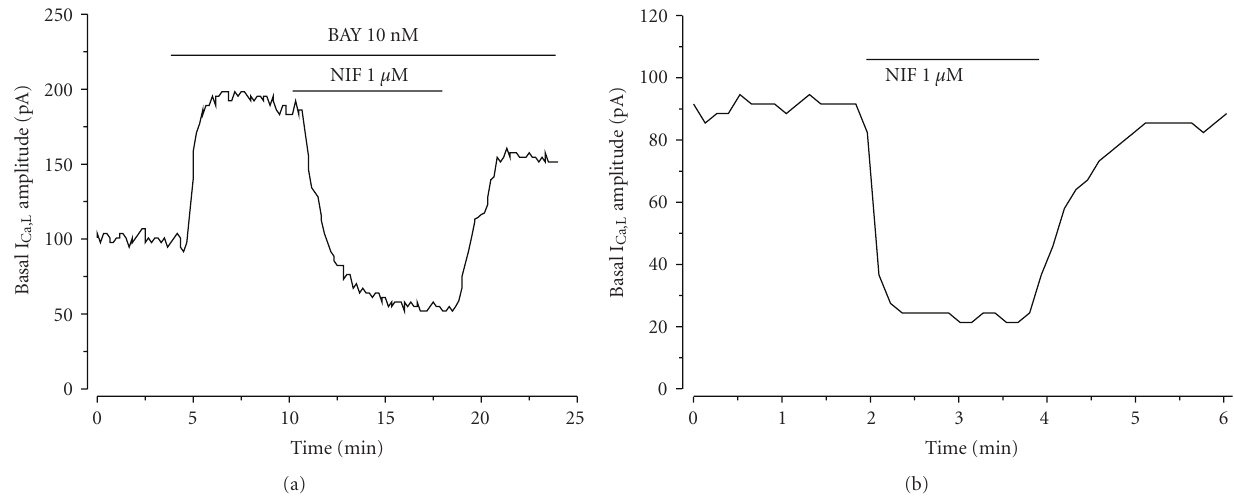
Figure 3: E ff ect of nifedipine and BAY on I Ca,L amplitude in A7r5 cells. Original records of I Ca,L measured in Patch-clamp experiments showing that: BAY (10nM) stimulates I Ca,L and nifedipine (NIF; 1 μ M) inhibits the BAY stimulation (a); Nifedipine (1 μ M) directly inhibits the basal I Ca,L